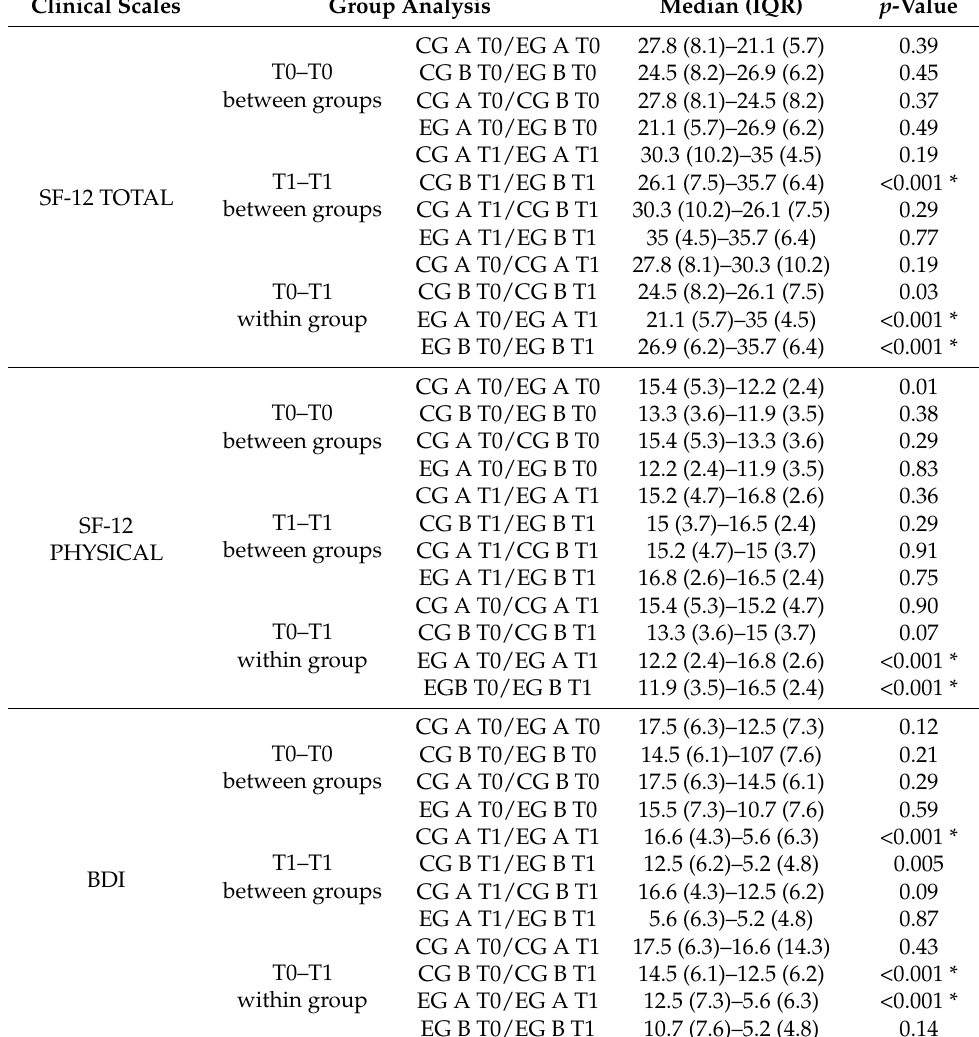
Table 3. Statistical comparison of changes in the clinical score of secondary outcome measures of